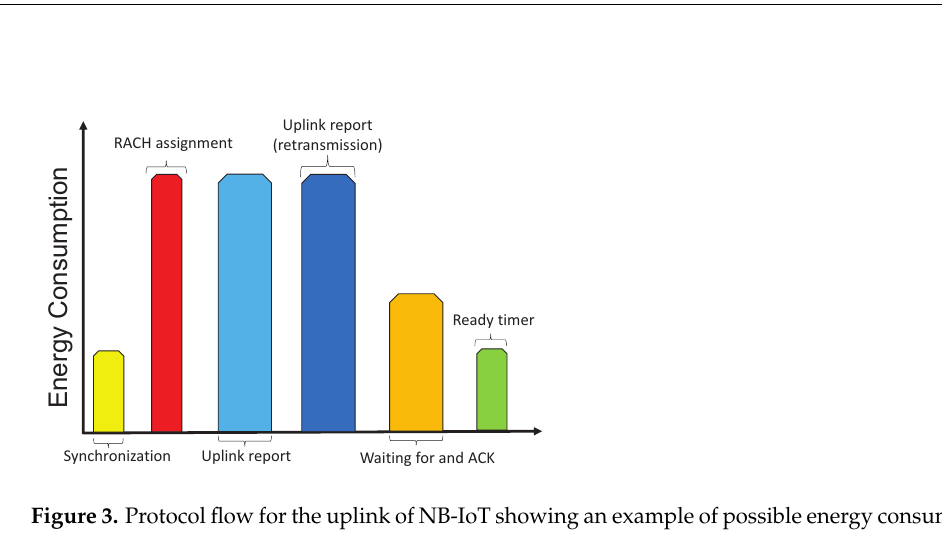
P Network = ( 1/ N DataPacket )